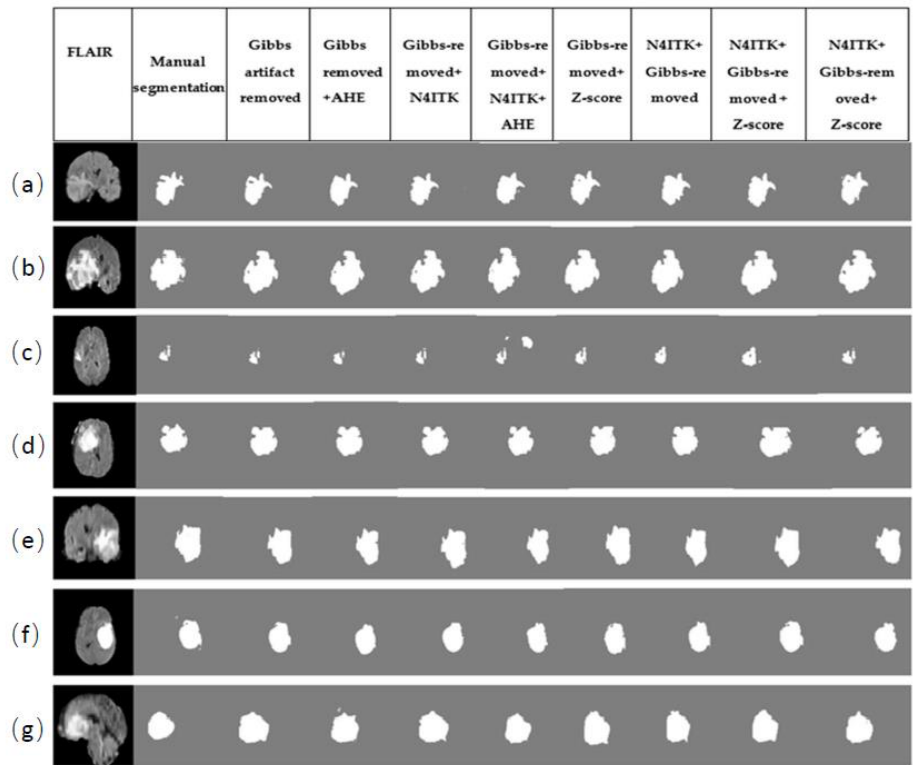
Figure 4. Comparison of prediction (segmentation) results produced by the sequences (1–8) used in this work. Each row (a)-(g) has MR images, ground truth labels and their corresponding segmentation results (from left to right).